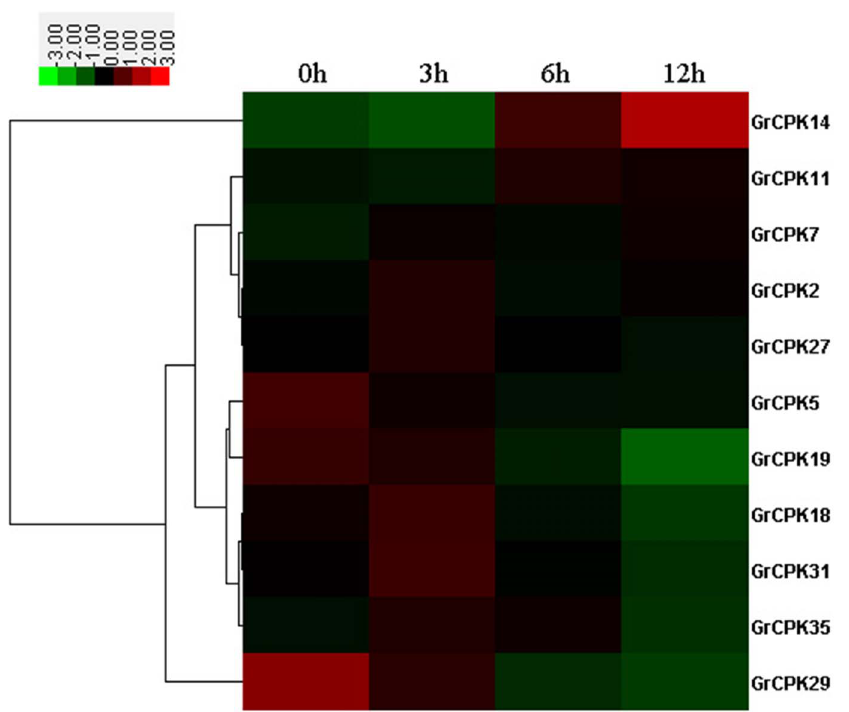
Figure 5. Expression profiling of 11 GrCPKs in leaves under 10 6 C treatment. The color bar represents the relative signal intensity values.